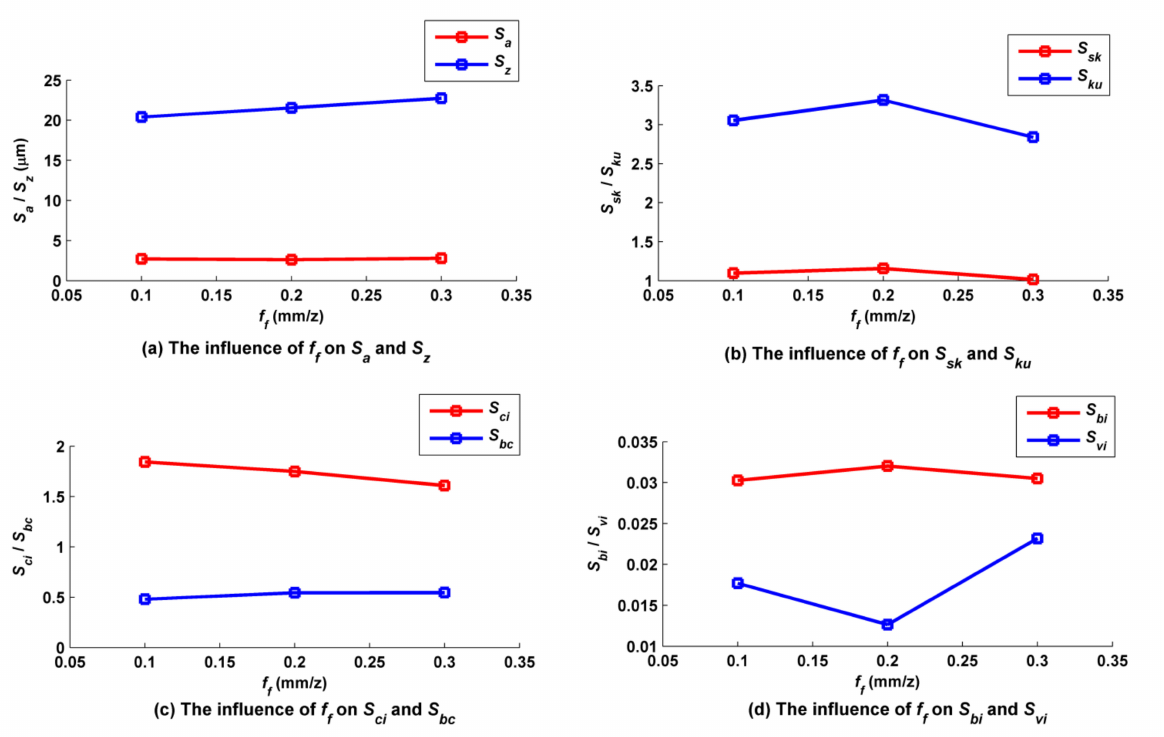
Figure 17. Influence of feed per tooth on ball-end trochoidal milling surface